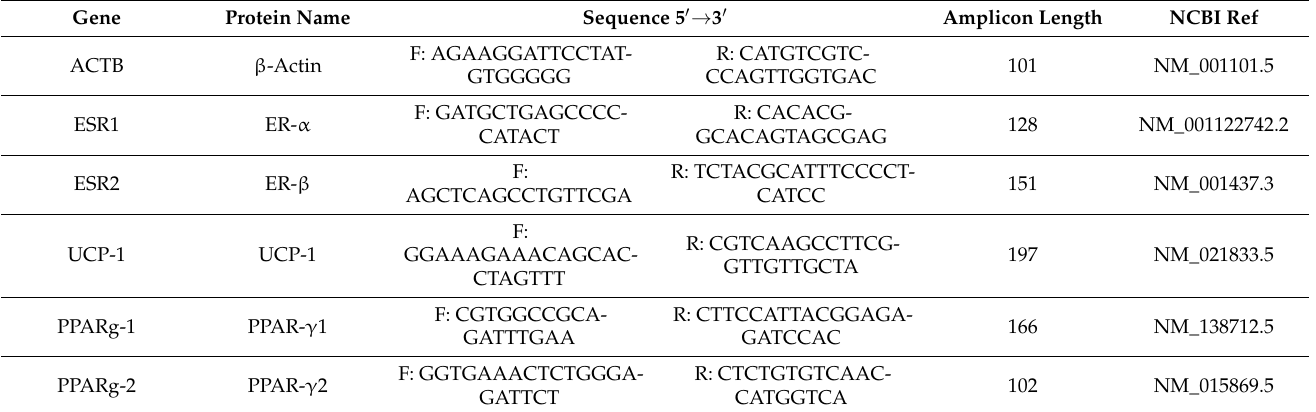
Table 1. Primer sequences used in qPCR experiments (by